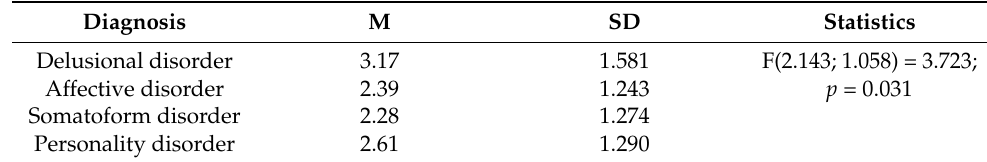
Table 8. Willingness to move to remote psychotherapy by diagnosis.